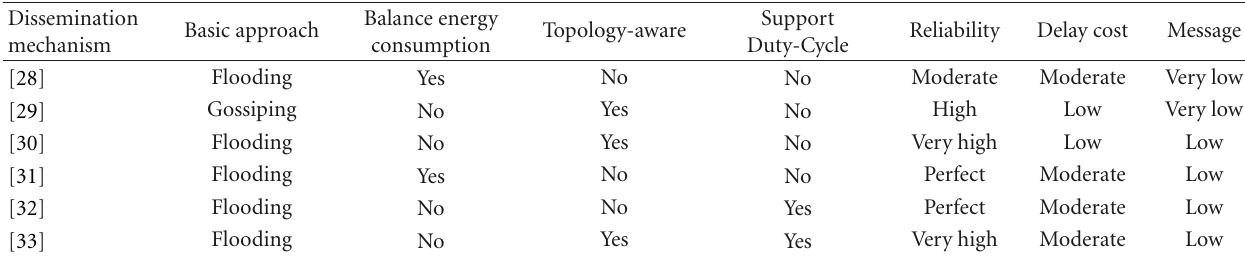
Table 2: Di ff erent message dissemination